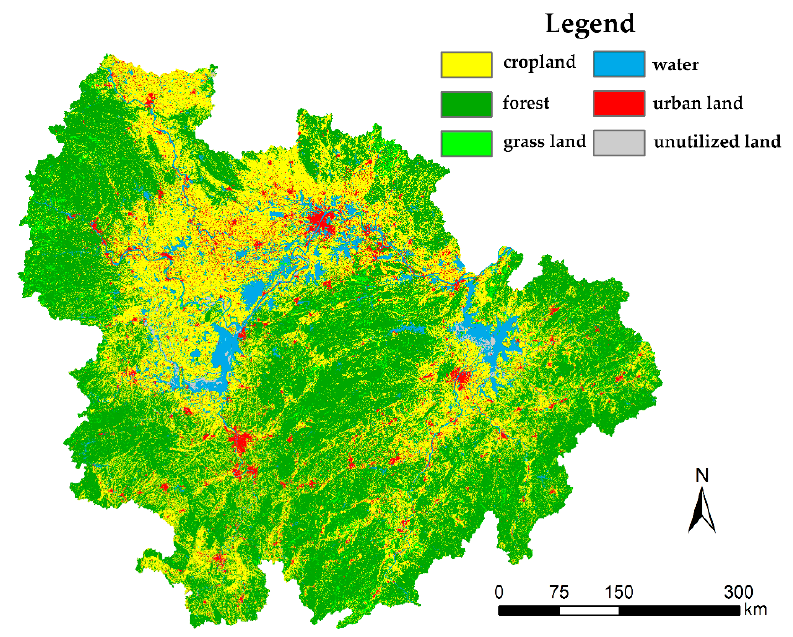
Figure 5. The simulation results in 2015.